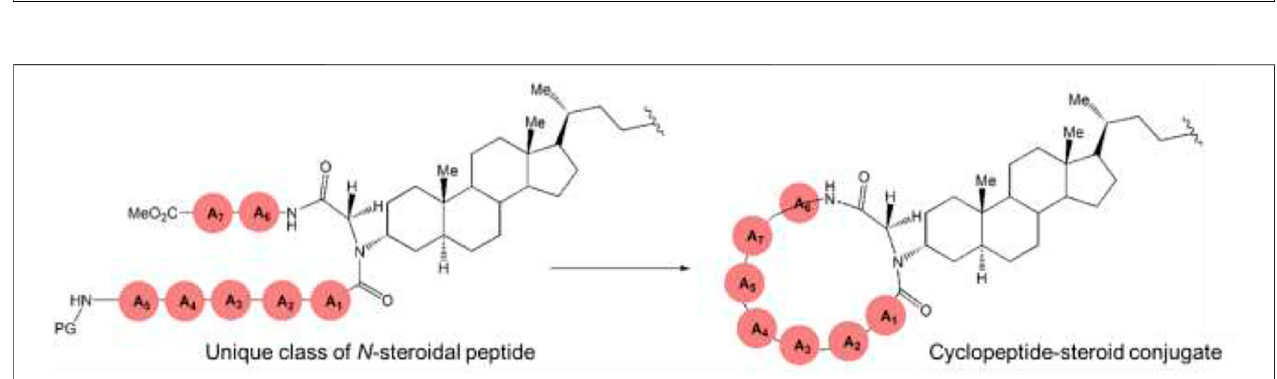
FIGURE 11 | Peptide-steroid conjugation. Multicomponent conjugation (MCC) of two peptide fragments previously linked to the steroid to construct a unique N -steroidal cyclopeptide.